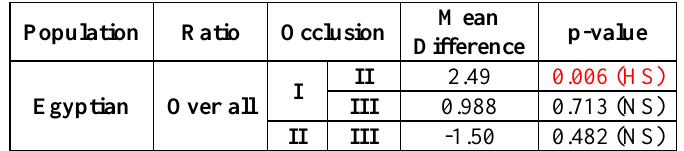
Table 5: Differences between the Angle classes of Egyptian population for overall ratio and their levels of significance determined by Tukey’s honestly significant difference